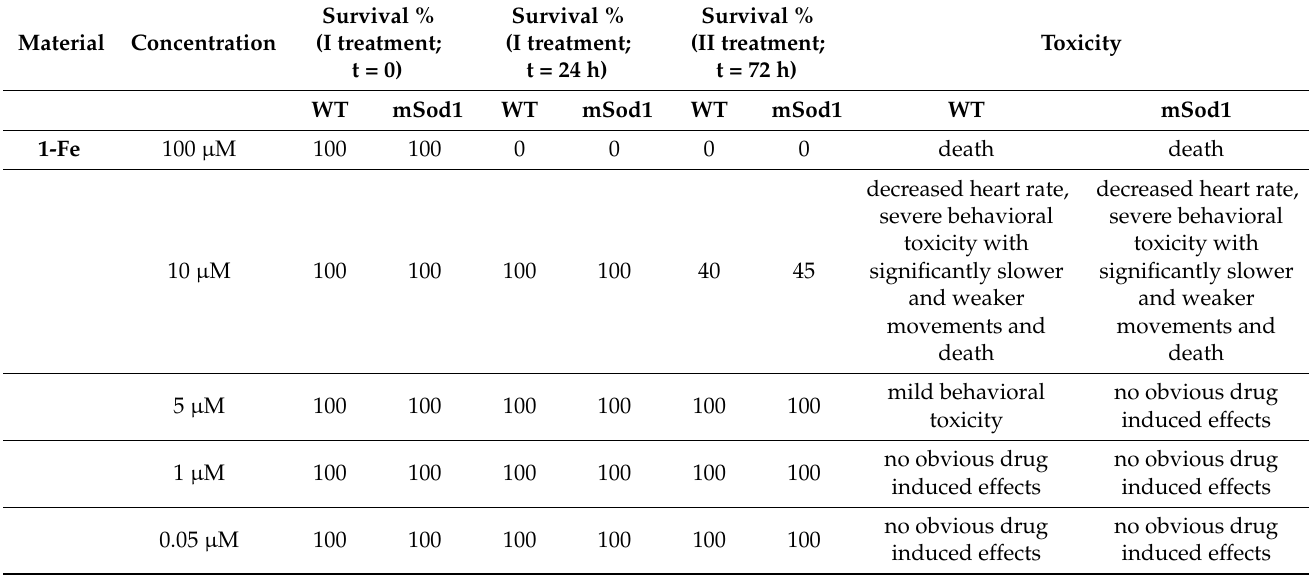
Table 1. Toxicity evaluation of 1-Fe treatment in WT and mSod1